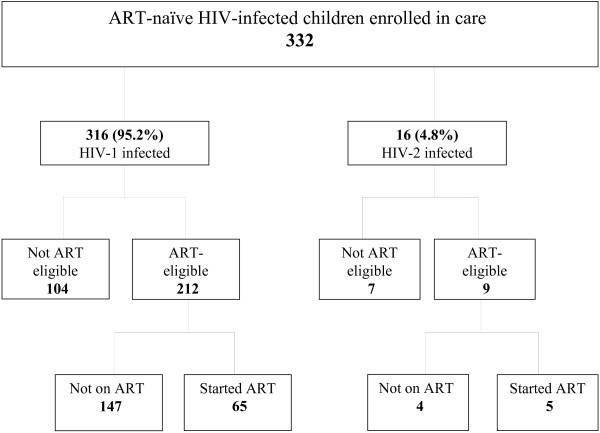
Flowchart of ART-naïve HIV-infected children < 15 years of age enrolled in the MRC Fajara paediatric HIV programme from June 2004 - September 2009.